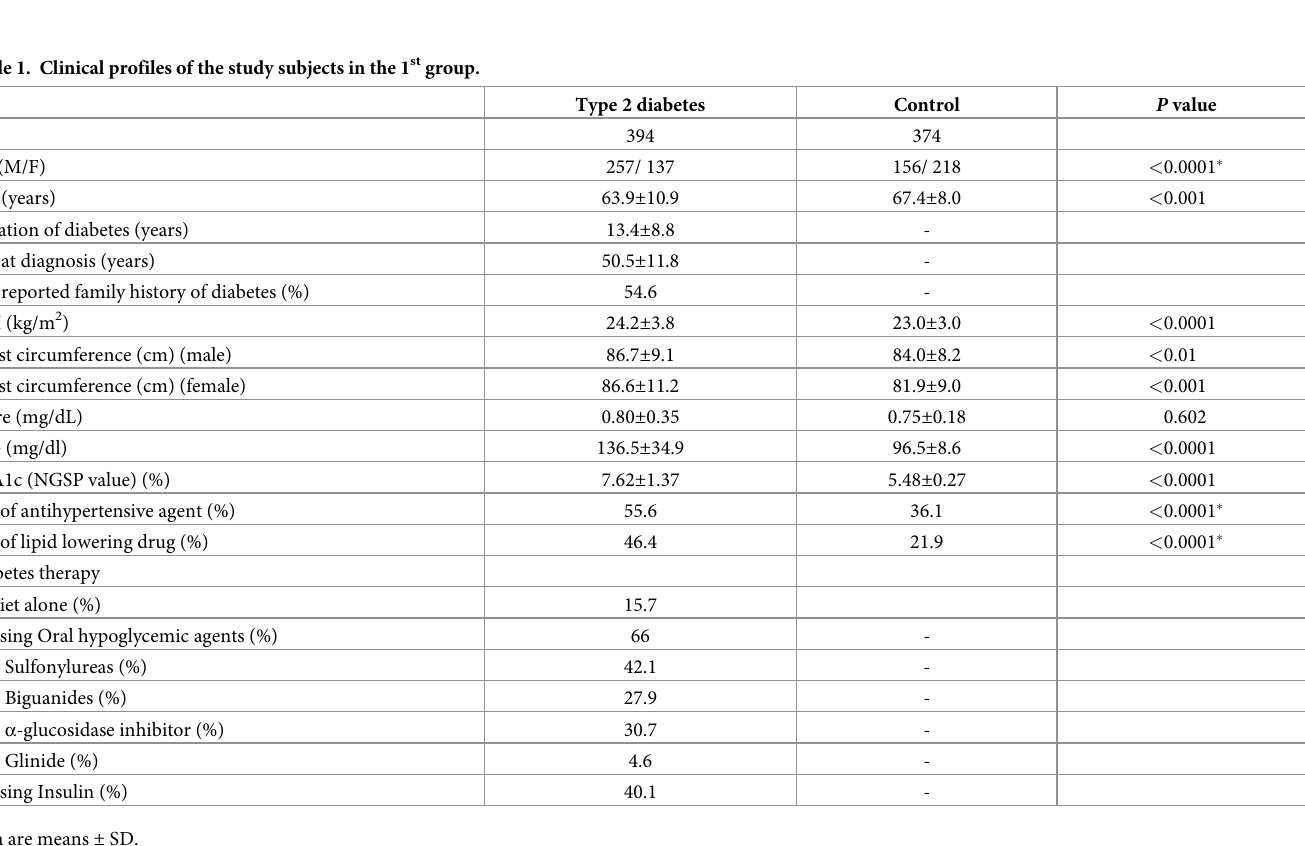
Table 1. Clinical profiles of the study subjects in the 1 st